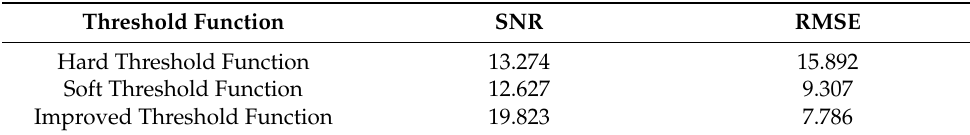
Table 2. Denoising results of the three threshold functions.